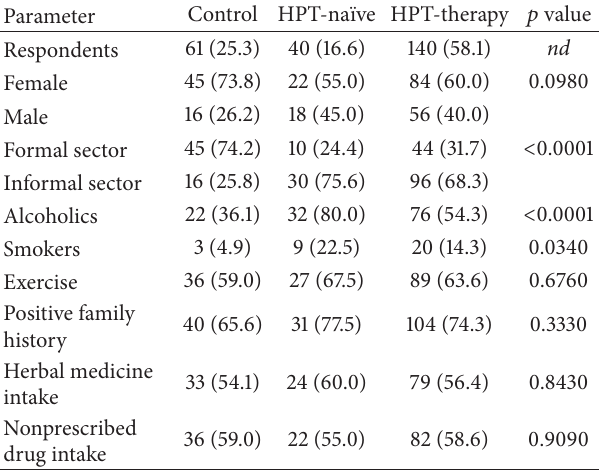
Table 2: Sociodemographic characteristics of the population under study stratified by hypertension and treatment